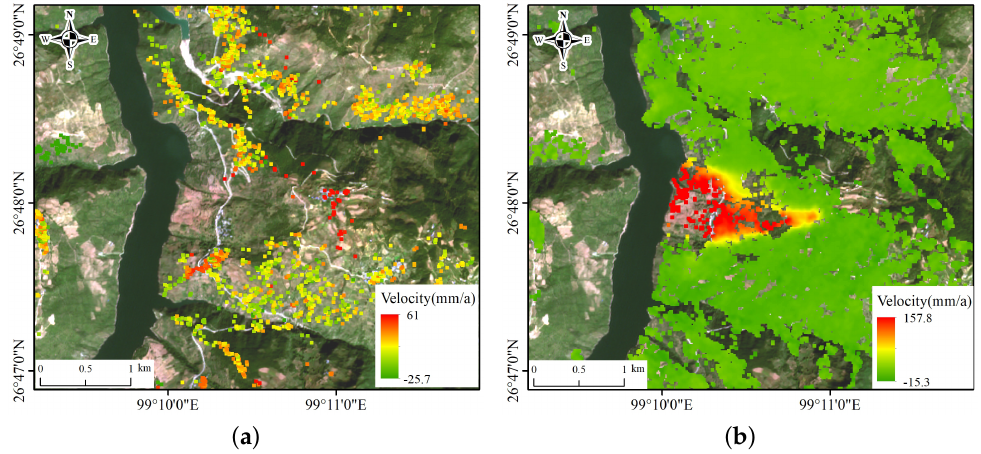
Figure 6. Monitoring results in LOS direction by PS-InSAR ( a ) and SBAS-InSAR ( b ), respectively. The annual average velocity results overlay the Sentinel-2 satellite data. The red raster shows uplifted deformation in the LOS direction, the green indicates